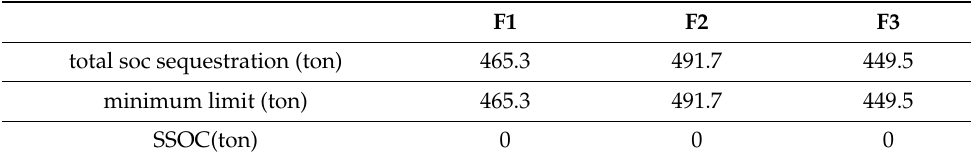
Table 11. Allocated soil organic carbon sequestration.